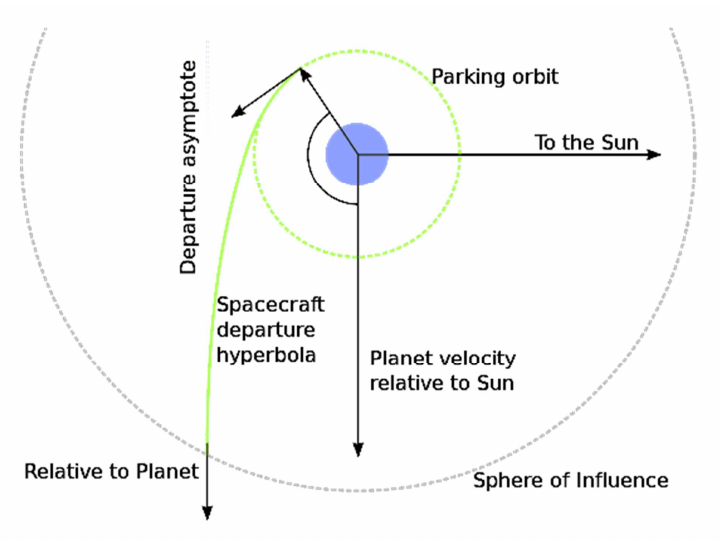
Figure 3. Departure of a spacecraft on a mission from an inner planet to an outer